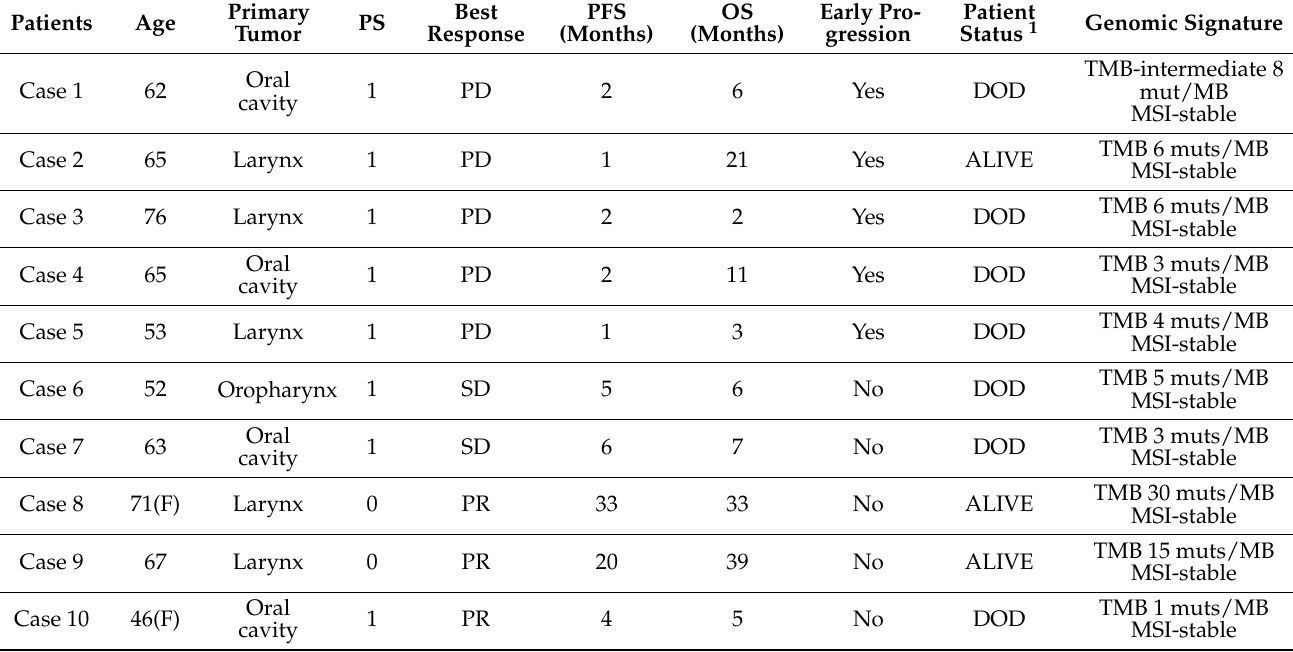
Table 2. Case series: clinicopathological features, molecular characteristics, and